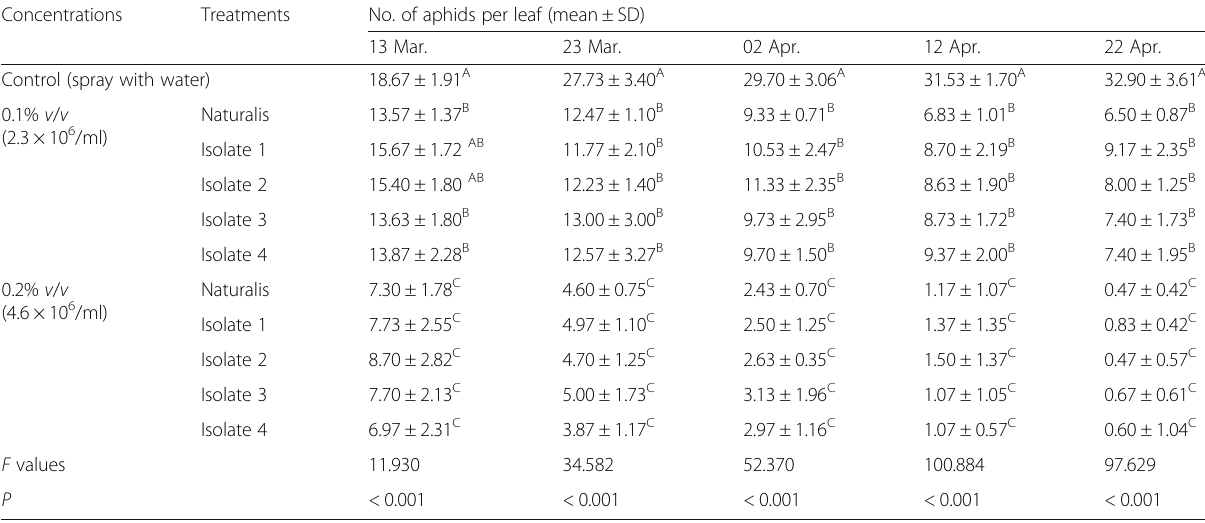
Table 2 Population dynamics of aphid, Macrosiphum rosae , on rose plants leaves treated with the four tested indigenous and one commercial Beauveria bassiana Concentrations